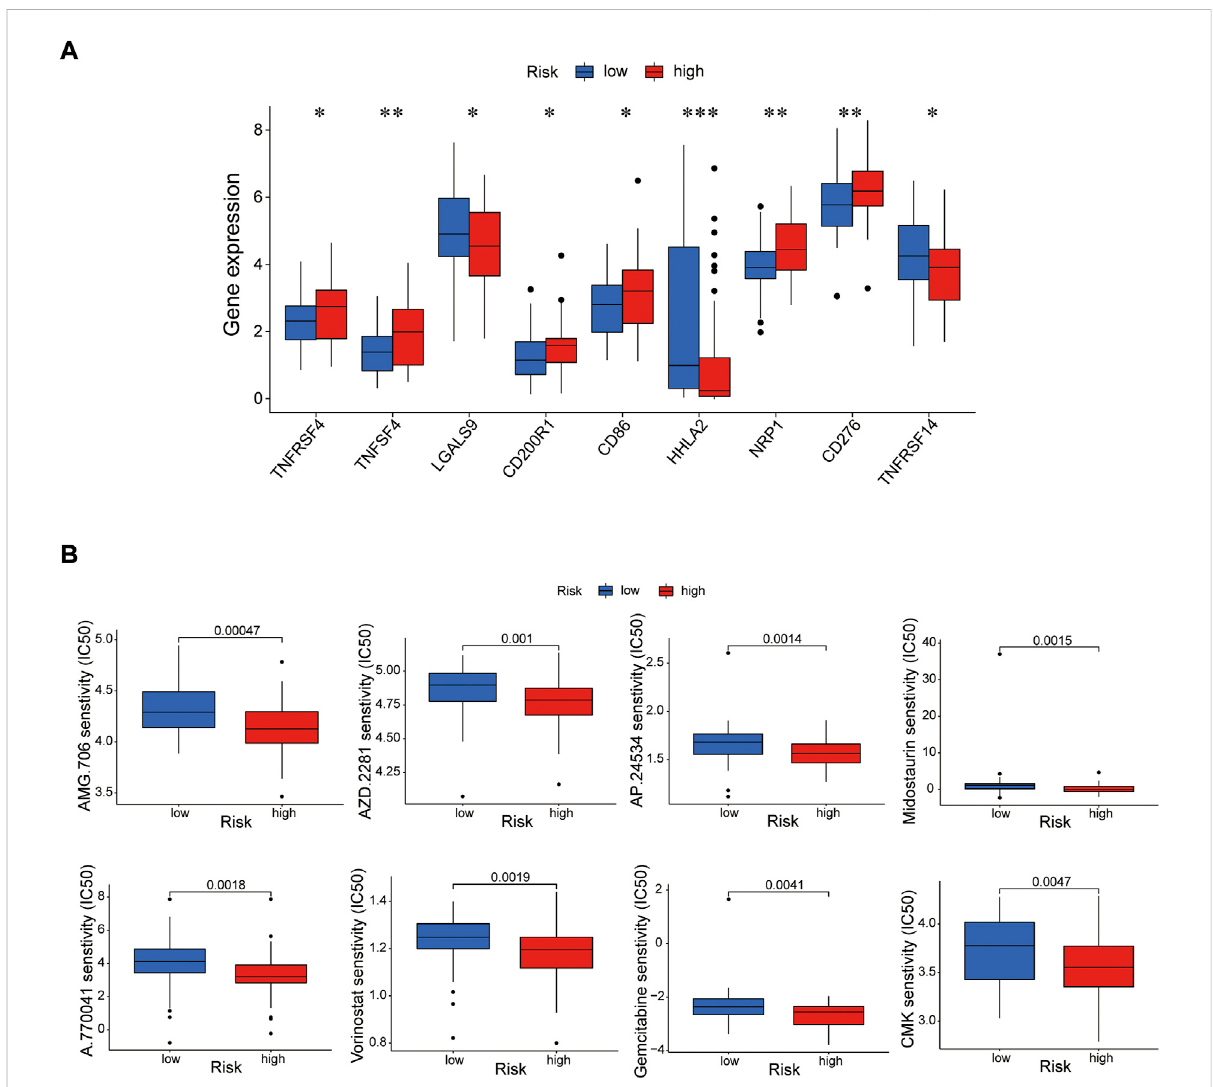
FIGURE 11 Investigation of tumor immunotherapy. (A) The analysis of immune checkpoints in the risk model. (B) The prediction of potential therapeutic drugs. * p < 0.05; ** p < 0.01; *** p <